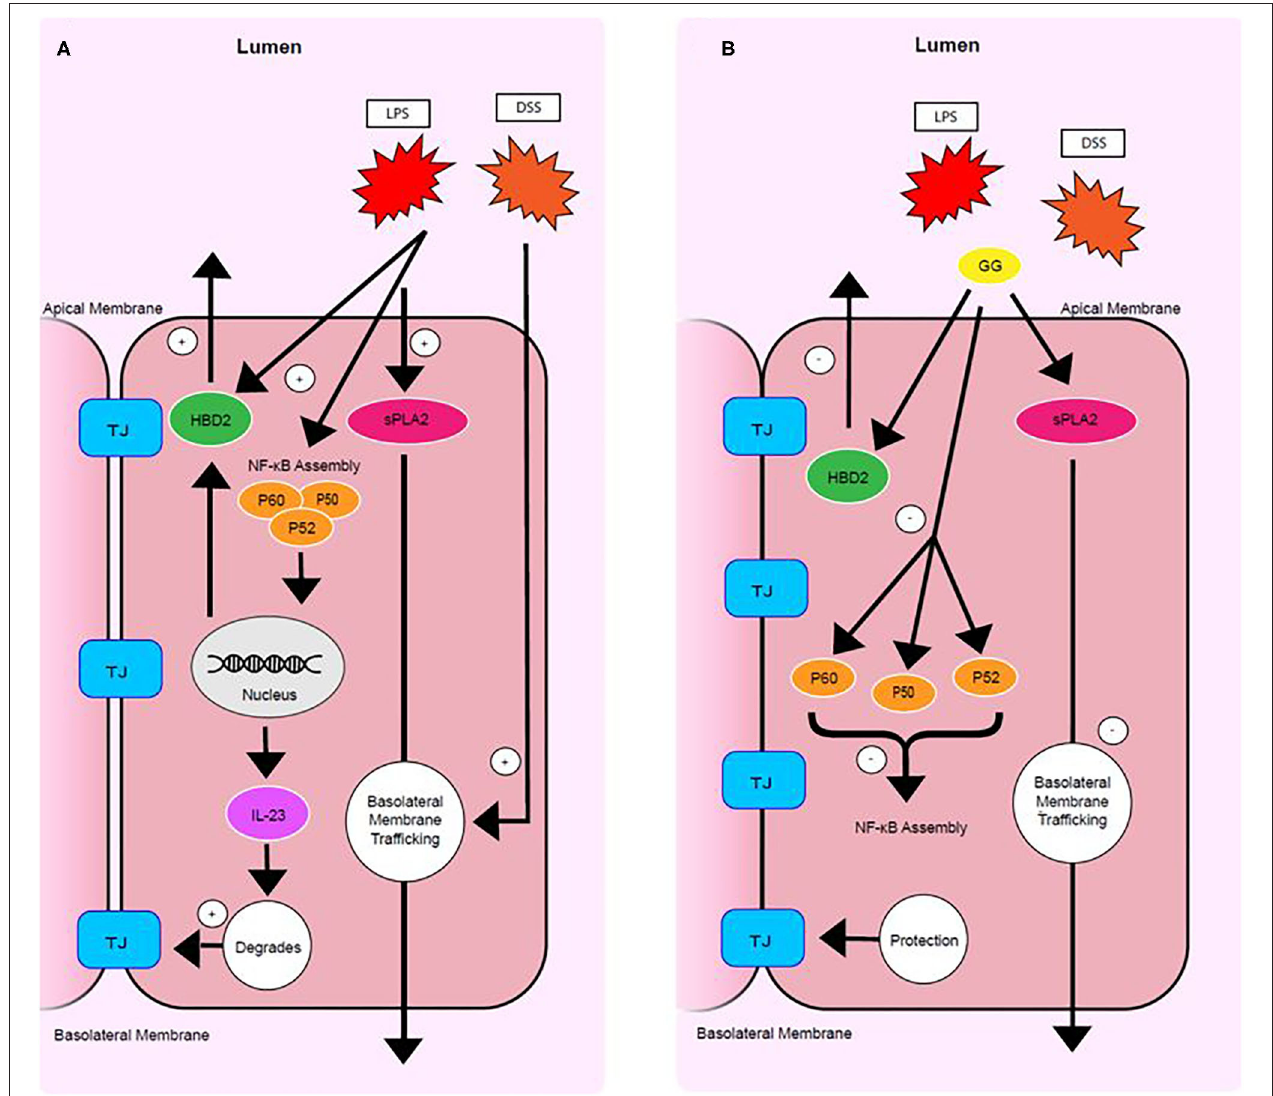
FIGURE 6 | Mode of action of ganglioside. Pro-inflammatory stimuli upregulate sPLA 2 trafficking, HBD-2 production, NF- κ B subunit production and assembly, IL23 signaling, and tight junction degradation (A) . Ganglioside protects mucosal integrity by (1) inhibiting secretion of HBD-2, (2) decreasing NF- κ B assembly, (3) lowering IL-23 production, and by (4) inhibiting trafficking of sPLA 2 to the basolateral membrane (B) . TJ. tight